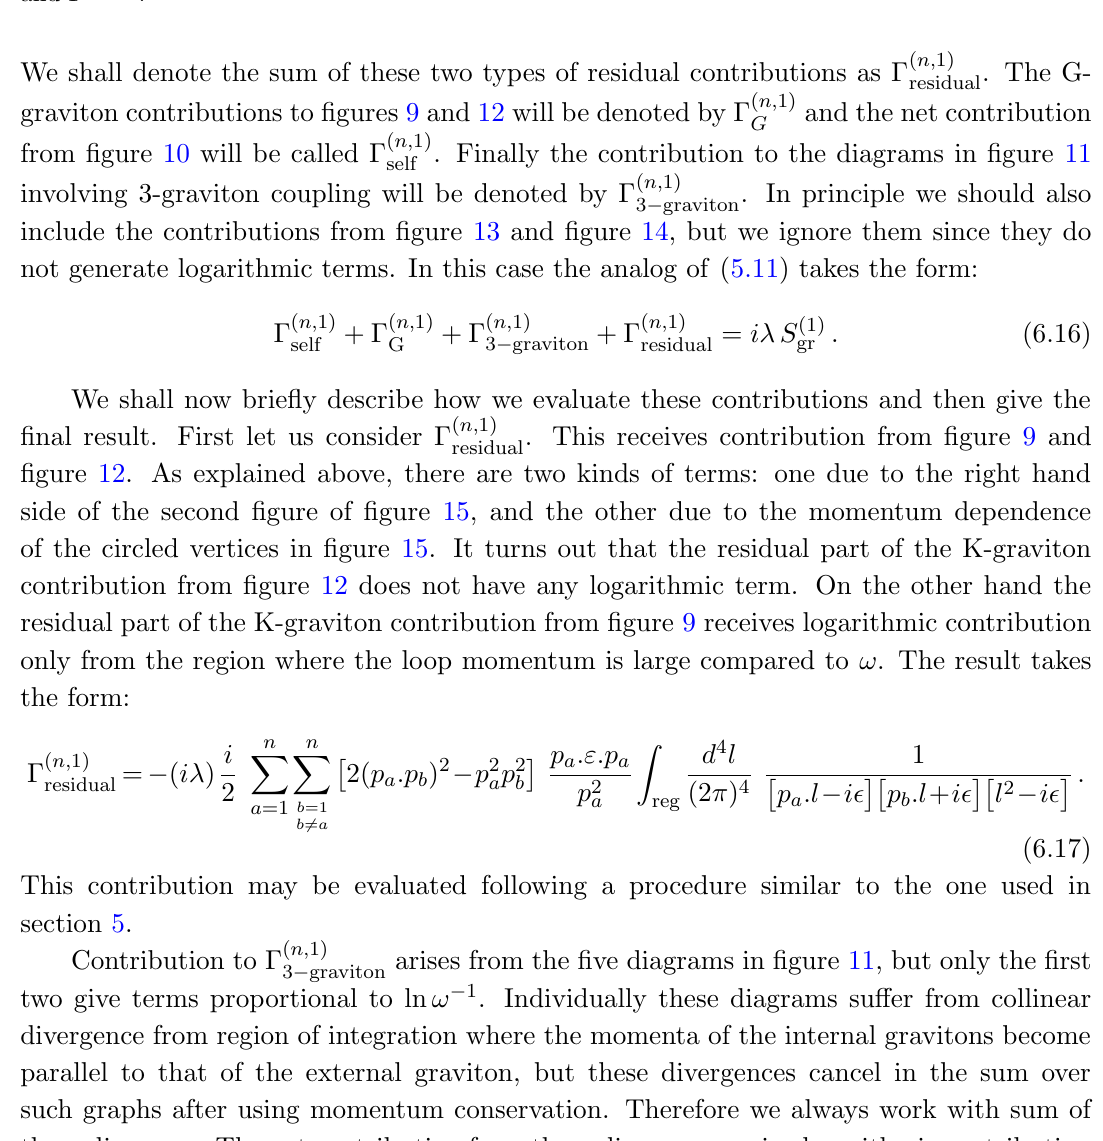
Figure 16 . Figure illustrating the di(cid:11)erence in the factorized K-graviton contribution to (cid:0) ( n ) and (cid:0) ( n +1)